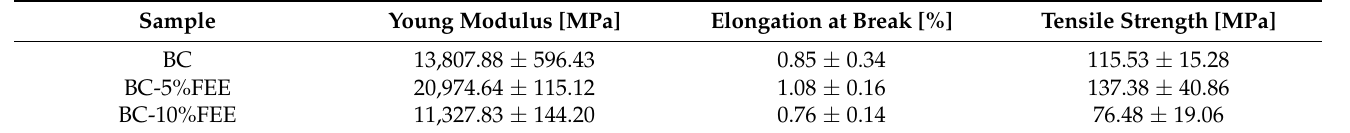
Table 2. Results of mechanical tests for BC-FEE and BC. Mean values ± standard deviation, n =